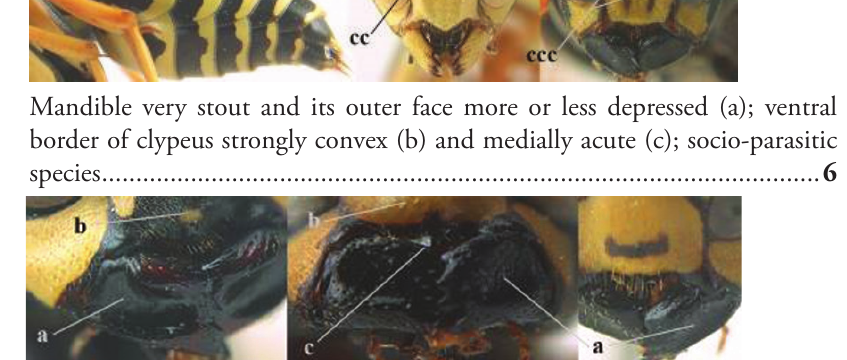
– Antenna with 13 segments (aa); metasoma with 7 visible tergites and sternites (bb); face and/or clypeus yellow (cc; but more or less blackish pattern present in P. atrimandibularis ccc); males .............................................................. 21